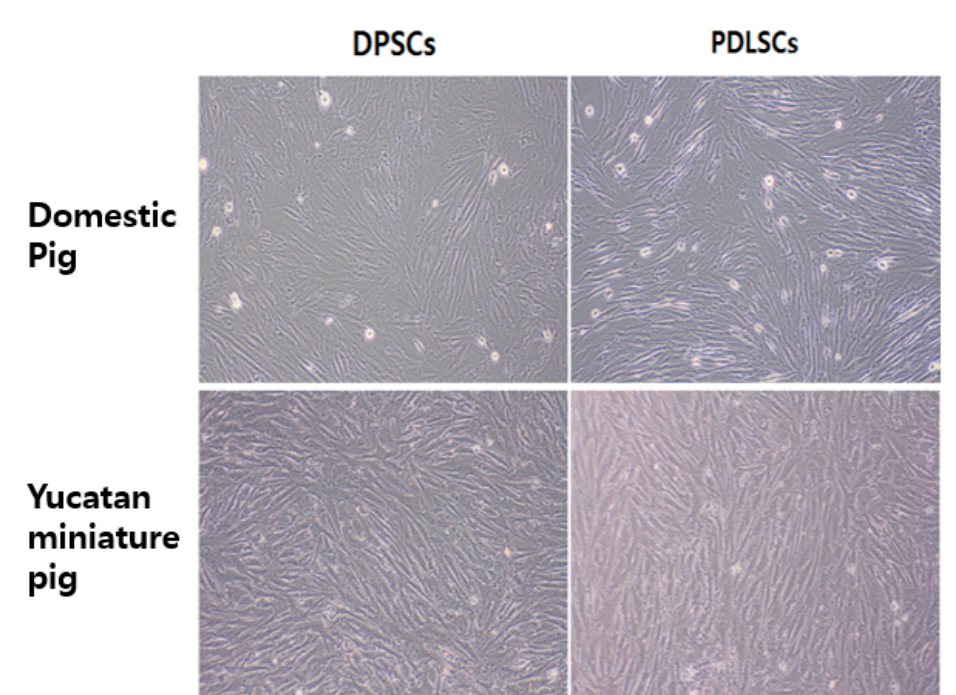
Figure 1. Scheme to compare the characteristics of the dental pulp stem cells (DPSCs) and periodon- tal ligament stem cells (PDLSCs) of the Yucatan miniature pig breed to those of the domestic farm pig breed.